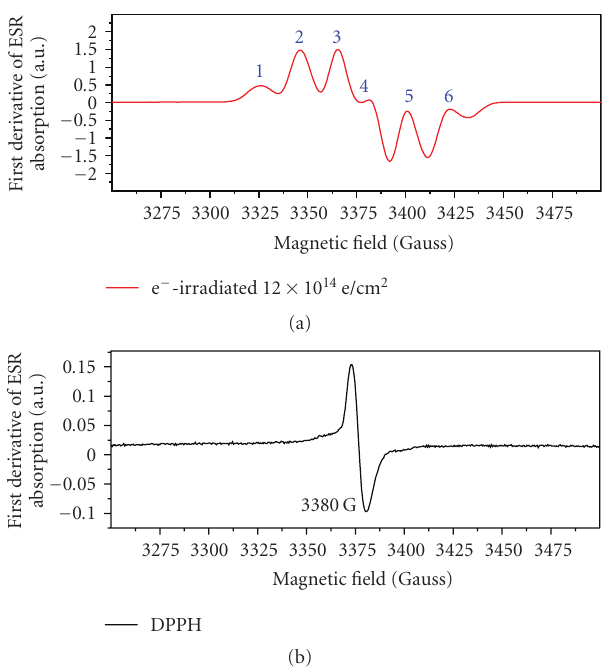
Figure 41: ESR spectrum of electron-irradiated (12 × 10 14 e/cm 2 ) L-threonine crystal.